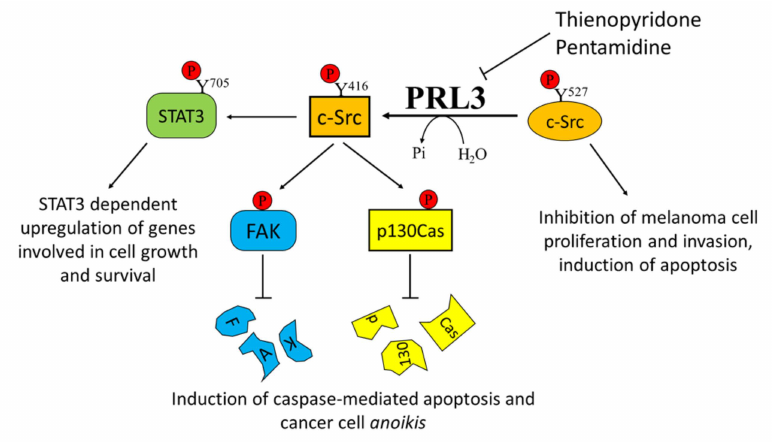
Figure 3. E ff ects of Phosphatase of Regenerating Liver-3 (PRL-3) targeting on melanoma progression. Elevated PRL-3 leads to Src activation through the downregulation of the synthesis of C-terminal Src kinase protein, which in turn leads to tyrosine phosphorylation of several proteins, including STAT3, FAK, and p130Cas. Thienopyridone and pentamidine derivatives, which act as PRL3 inhibitors, are e ff ective in inhibiting melanoma cell proliferation, survival, and